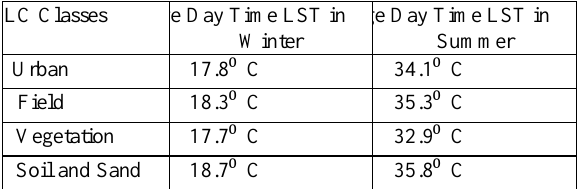
Figure 9. Urban built up identified by the ISA map matched with the spatial pattern of urban class from Figure 8. The FVC map showed presence of vegetation in areas of low built